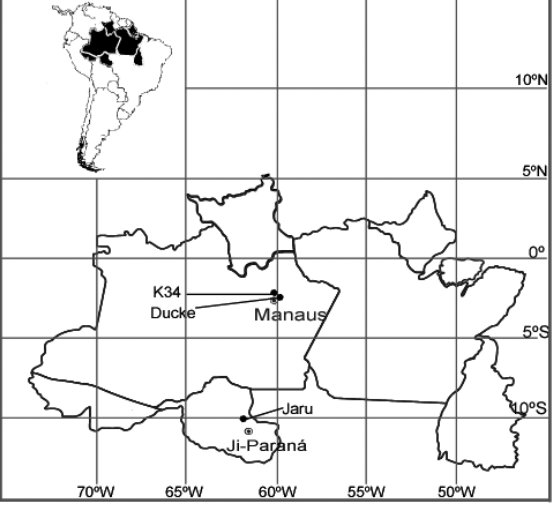
Fig. 1 – Location of study